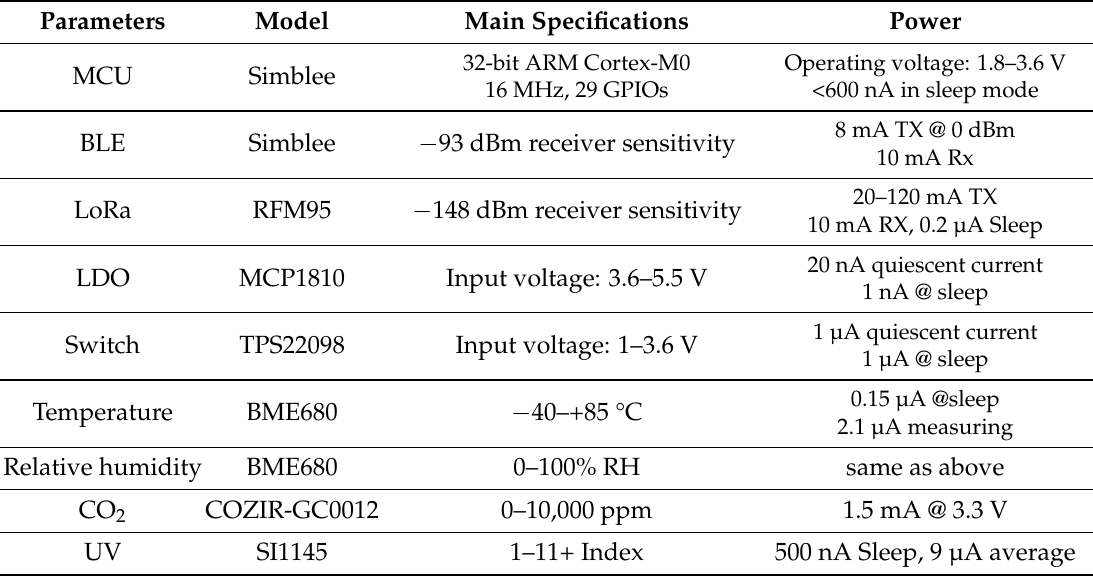
Figure 4. The Safe Node schematic. Table 1. Key components used in the Safe